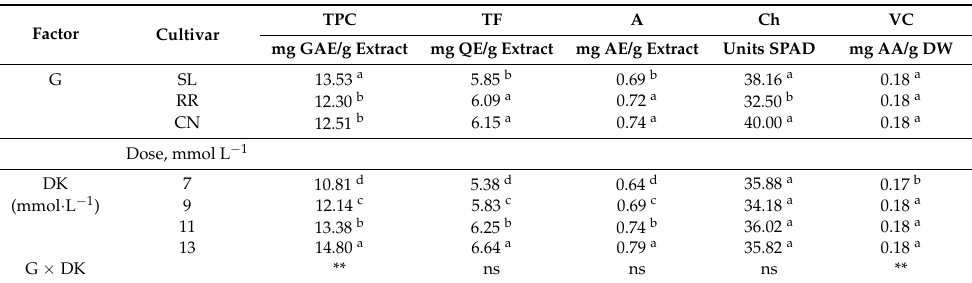
Table 3. Effect of genotype (G), doses of K + (DK), and interaction (G × DK) on nutraceutical components of hydroponic